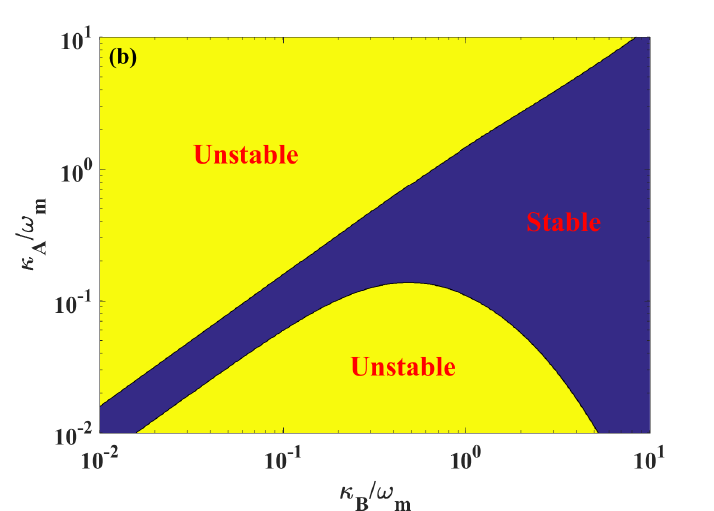
Figure 6. S 2 ( ω ) ( a ) and the maximum eigenvalue of Equation (7) ( b ) as a function of the cavity decay rate κ j . The detunings are set to the red and blue sideband ∆ A = − ∆ B = ω m , respectively. In picture ( b ), the yellow area means the maximum eigenvalue of Equation (7) is non-negative. According to the Routh–Hurwitz stability criterion [41], the system becomes instable in the long time limit. Conversely, the blue area denotes the system is stable. Other parameters are the same as Figure 5.